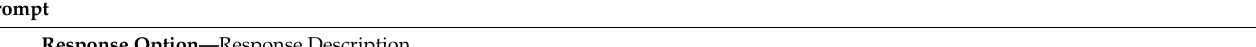
Table 1. Brief, Non-Technical Descriptions provided to